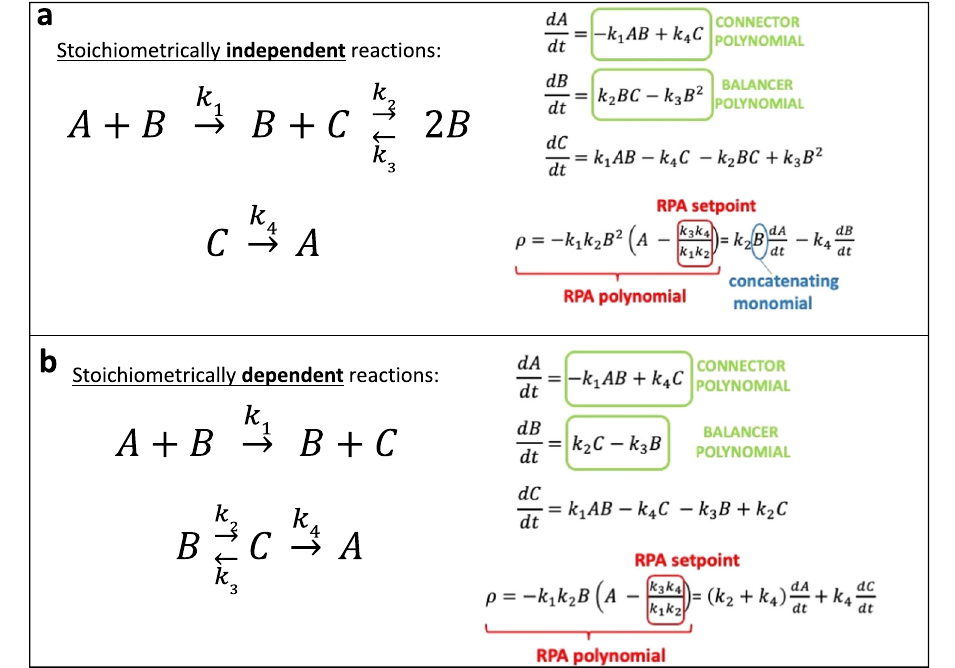
monomial(B) is thereforerequired to reconcile the twoinvariantsto constructthe RPA polynomial. b A modi fi ed version of the CRN, with identical underlying topology. In this case the connector polynomial (dA/dt) and the balancer poly- nomial(dB/dt)arestoichiometricallydependent,sincethecomplex ‘ C ’ contributes tobothinvariants,andistherebyeliminatedwithintherowspanofthesystem.Asa consequence, the RPA polynomial resides in the system ’ s